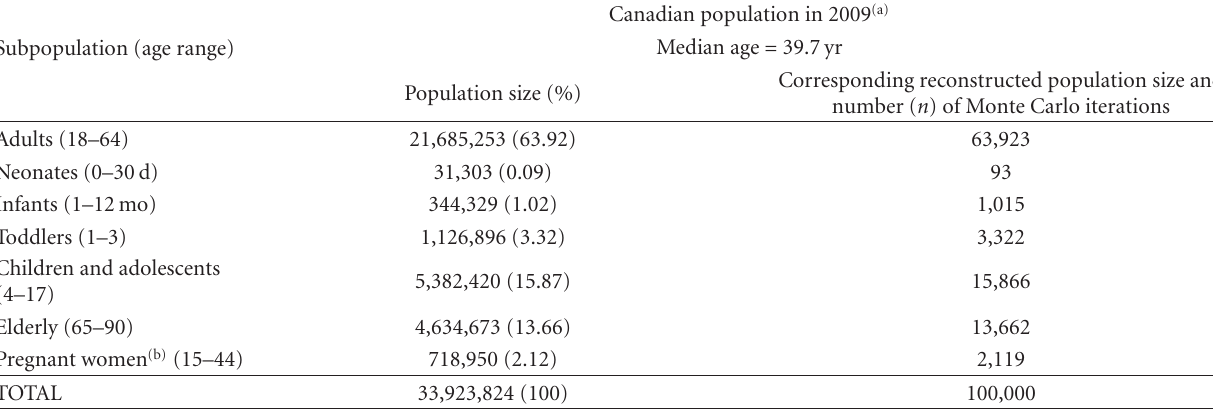
Table 3: Reconstruction of the hypothetical populations of 100,000 people with the Canadian demographic